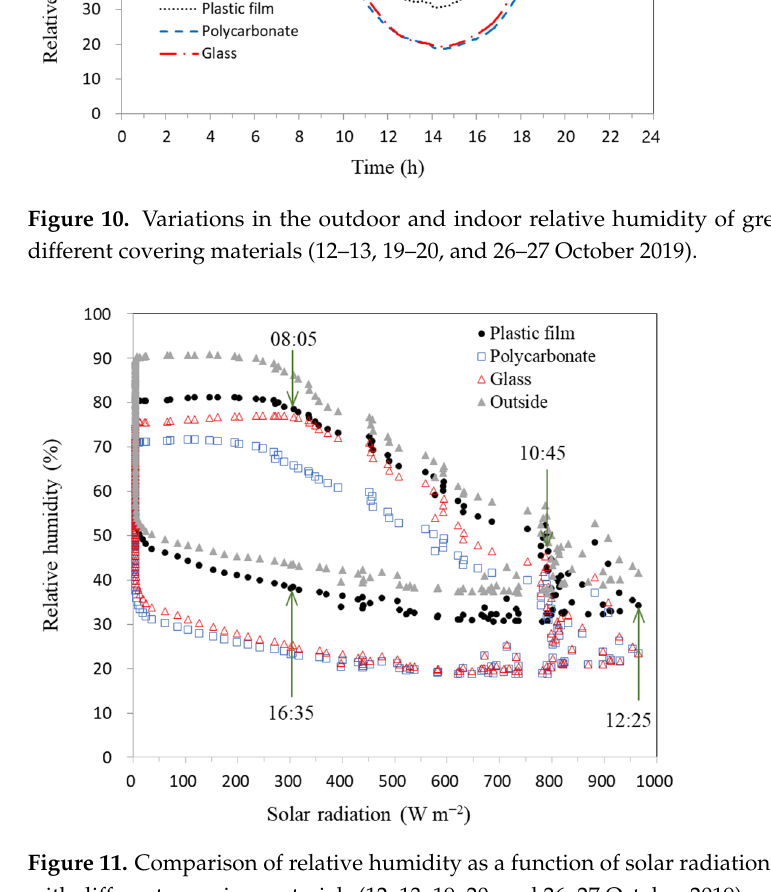
Figure 12. Comparison of relative humidity as a function of outdoor air temperatures in green- houses covered with different covering materials (12 − 13, 19 − 20, and 26 − 27 October 2019).